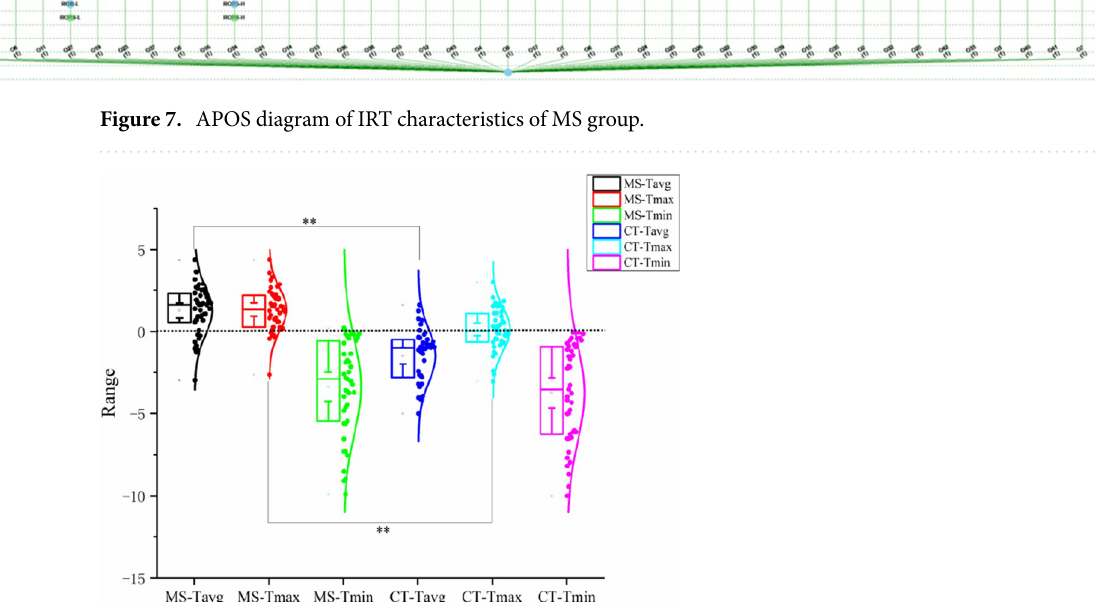
Figure 8. Distribution map of temperature difference between face and